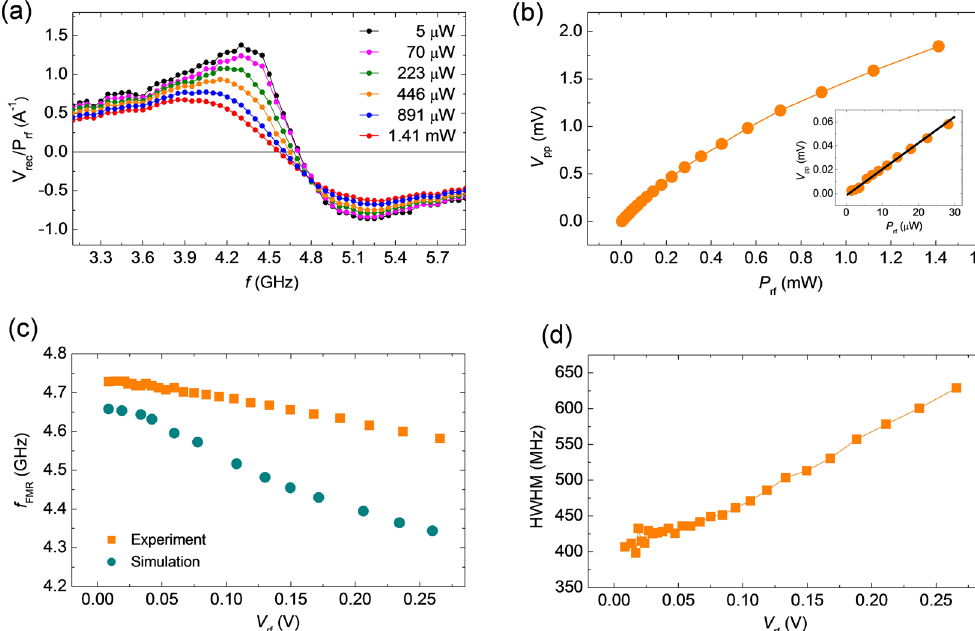
Figure 3. Experimental resonance spectra and dynamic parameters versus power. ( a ) Plot of experimentally measured V rec , rescaled by 1/ P rf , versus f for different values of P rf . ( b ) Peak-to-peak value ( V pp ) of V rec as a function of P rf . Inset shows the magnified graph of the same in lower P rf regime. Solid line is a guide to eye for showing linear increment of V pp with P rf . ( c ) Plot of experiment and simulation results show the variation of FMR frequency ( f FMR ) as a function of V rf . ( d ) Plot of HWHM as a function of V rf